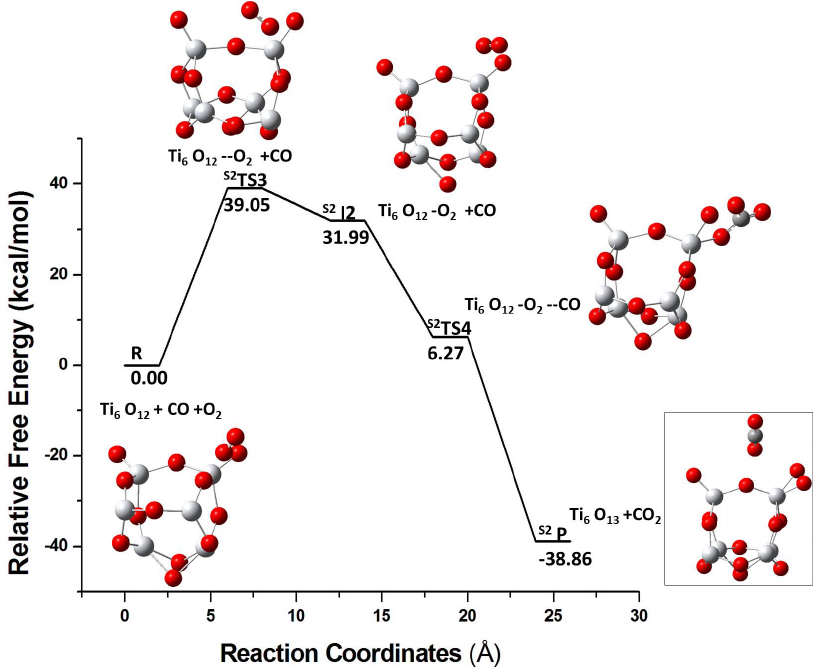
Figure 8. The energy profile for the reaction of S2 isomer with O 2 followed by reaction with the CO molecule. R, S 2 TS3, S 2 I2, S 2 TS4, and S 2 P represents reactants, transition state 3, intermediate 2,transition state 4, and product,